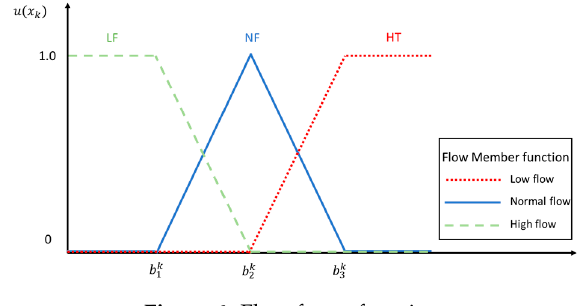
Figure 6. Flow fuzzy function.